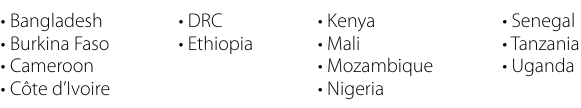
Table 3 Baseline JEE scores for 13 target countries in IPC and AMS using 2016 JEE